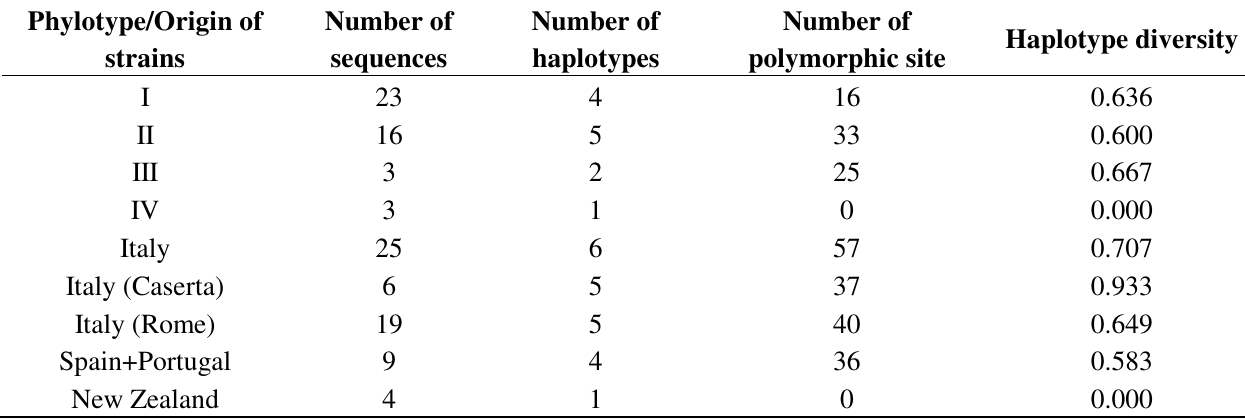
Table 3. Genetic diversity observed within Xanthomonas arboricola pv. juglandis according to phylogenetic reconstruction (phylotypes) and geographic origin of the